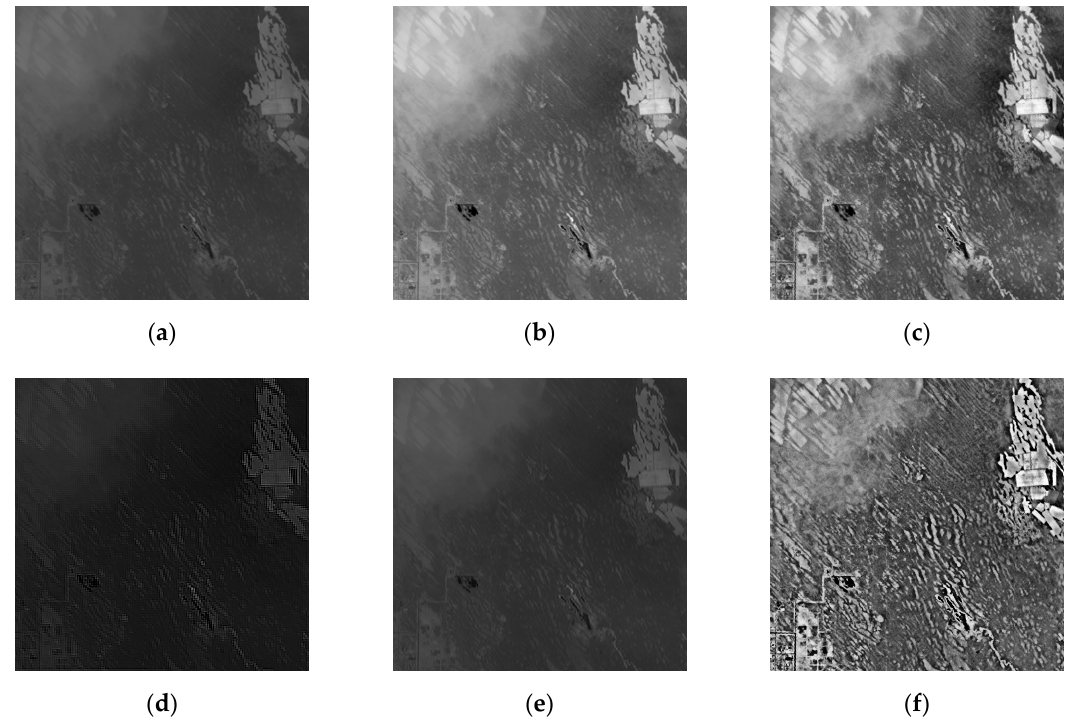
Figure 3. Comparison of different algorithms to cloud: ( a ) original image (real cloud image 2); ( b ) improved homomorphic filtering algorithm (IHF); ( c ) improved retinex algorithm (IR); ( d ) SWT + DWT algorithm (SD); ( e ) Mallat algorithm (M); ( f ) proposed method.